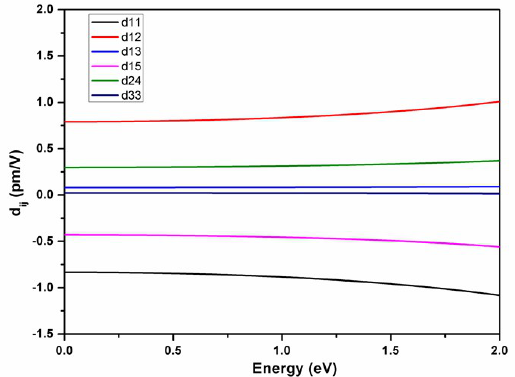
Figure 8. Calculated frequency-dependent second harmonic generation coefficients for Na 4 Yb(CO 3 ) 3 F.